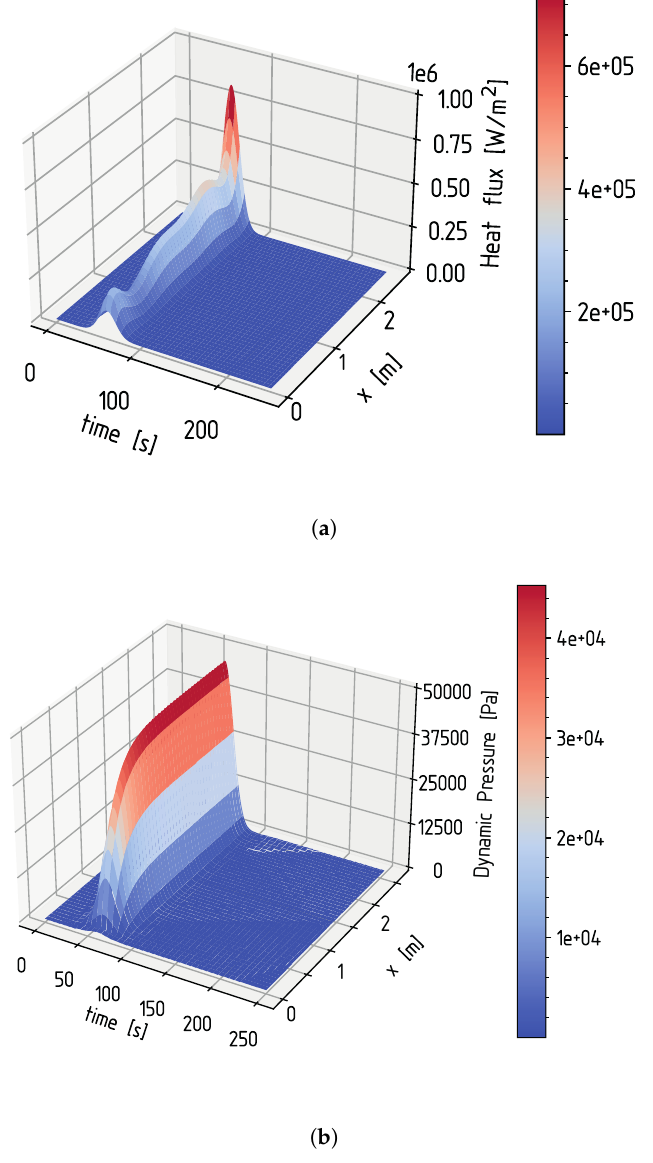
Figure 8. ( a ) Heat flux distribution along the ADD longitudinal coordinate as a function of time; ( b ) dynamic pressure distribution along the ADD longitudinal coordinate as a function of